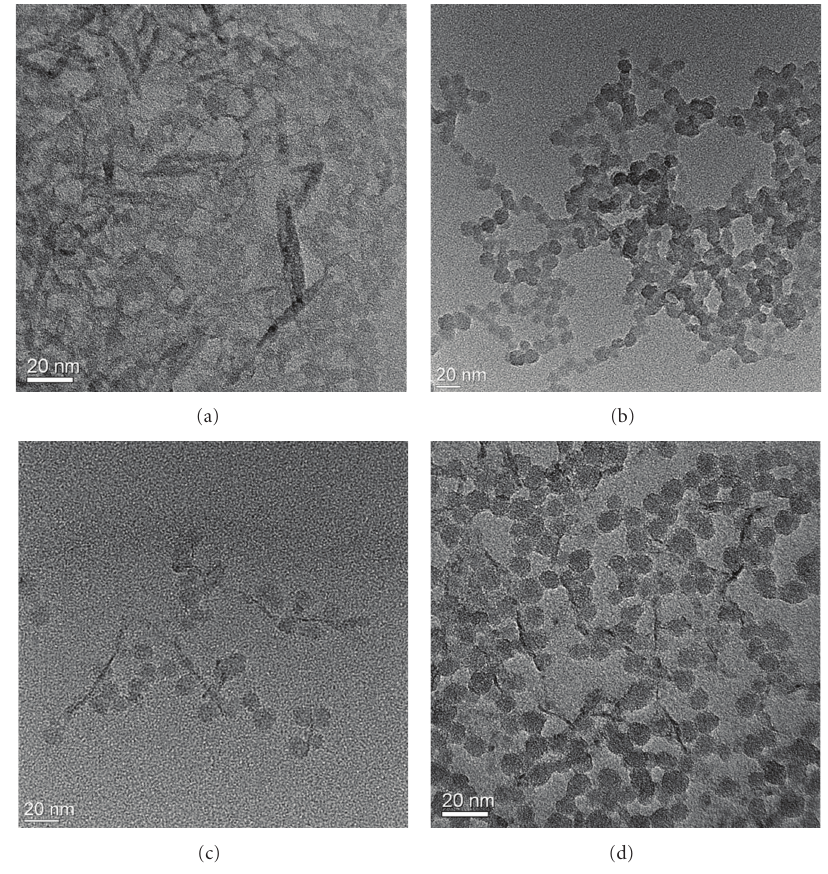
Figure 1: TEM micrographs: (a) TiO 2 , (b) SiO 2 , (c) ST 1.5, and (d) ST 3